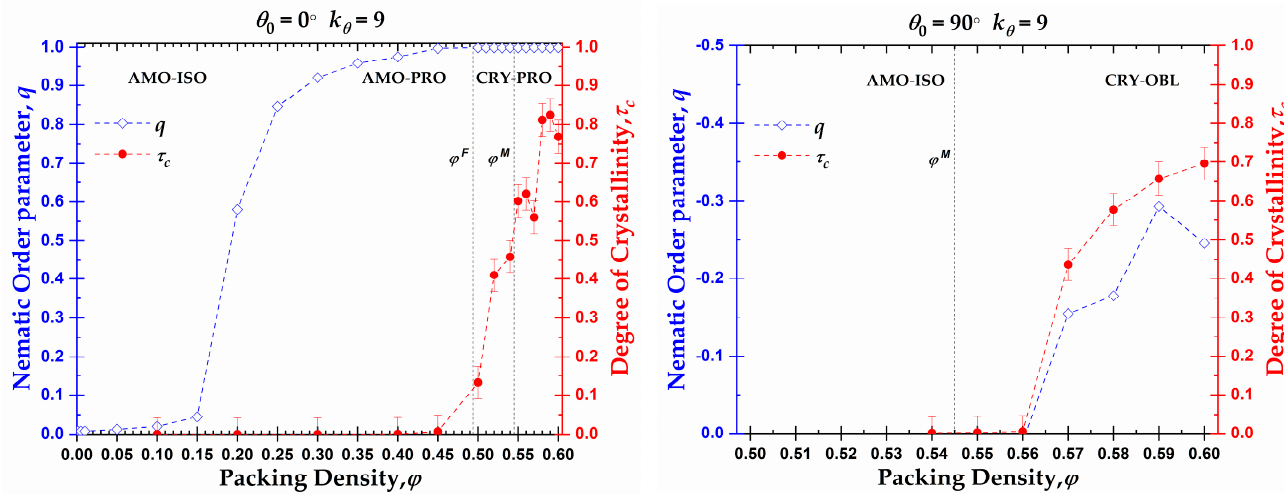
Figure 11. Orientational order parameter, q (( left ) y -axis, blue color), and crystallinity, τ c (( right ) y -axis, red color), as a function of packing density, ϕ , for 100-chains N av = 12 systems of semi-flexible chains with bending constant k θ = 9 and equilibrium bending angle θ 0 = 0 ◦ ( left ) and θ 0 = 90 ◦ ( right ). Dashed lines connecting points are used as visual support. Vertical dashed lines correspond to the freezing ( ϕ F monomers ≈ 0.494 ) and melting ( ϕ M monomers = 0.545 ) transition for monomeric hard spheres [29] .